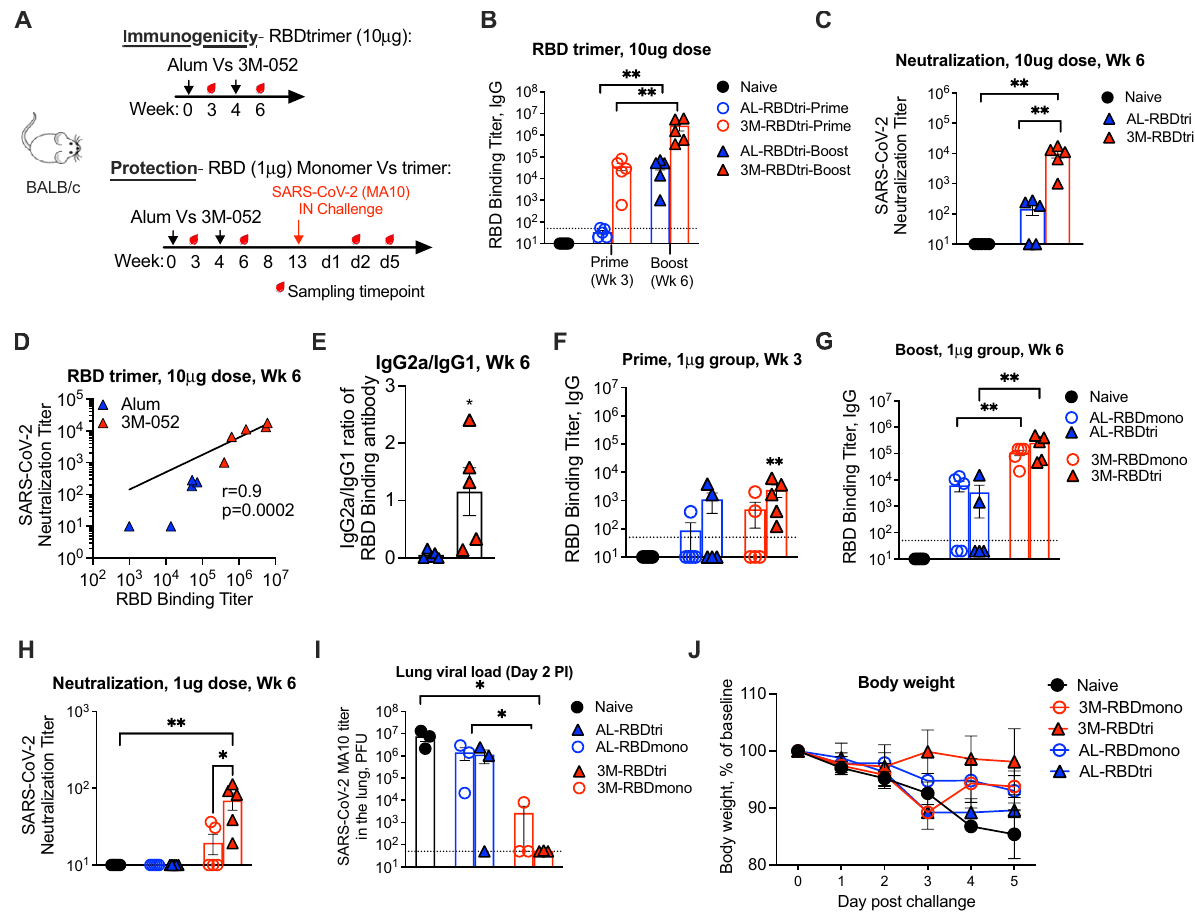
Fig. 2 RBD trimer adjuvanted with Alum-3M-052 induces a robust neutralizing antibody response and provides protection against SARS-CoV-2 challenge in mice. A The experimental schedule representing the timeline for the immunizations (study 1) and SARS-CoV-2 (MA10) challenge (study 2). Each immunization group has fi ve animals ( n = 5 mice per group). Study 1 ( B – E ): 6-week-old female BALB/c mice were immunized with RBD trimer (10 µ g/mice) either with Alum (blue) or with 3M-052-Alum (red) via intramuscular route at weeks 0 and 4. B Endpoint IgG titers against SARS-CoV-2 RBD measured in serum collected at week 2 post-prime and week 2 post-boost immunizations. Each sample was analyzed in duplicates. C Neutralization titer against live mNeonGreen SARS-CoV-2 virus. Each sample was analyzed in duplicates. D Correlations between neutralization titer and ELISA binding titers of RBD trimer antigen either with Alum (blue) and 3M-052 (red) adjuvants. The Spearman rank test was used to perform correlation analysis. E Bar graph shows the ratio of SARS-CoV-2 RBD-binding IgG2a and IgG1 antibody measurements. Each sample was analyzed in duplicates. Study 2 ( F – J ): Six-week-old female BALB/c mice were immunized either with RBD trimer or RBD monomer (1 µ g/mice) adjuvanted either with Alum (blue) or with 3M-052-Alum (red) via intramuscular route at weeks 0 and 4. Immunized mice were mock-infected, infected with 10 5 PFU SARS-CoV-2 MA10. F – G Endpoint IgG titers against SARS-CoV-2 RBD measured in serum collected at week 2 post-prime ( F ) and week 2 post-boost ( G ) immunizations. Each sample was analyzed in duplicates. (H) Neutralization titer against live mNeonGreen SARS-CoV-2 virus. Each sample was analyzed in duplicates. Circles indicate week 2 post- prime and fi lled triangle indicates week 2 post-boost immunizations. (I-J) Lung SARS-CoV-2 (MA10) viral titers of vaccinated animals compared to unvaccinated (I) and percent starting weight (J). In both studies, the black, blue, and red circles indicate naïve controls, alum, and alum-3M-052, respectively. Data are mean ± SEM. A two-sided Mann – Whitney U -test was used to compare between groups, * p < 0.05 and ** p < 0.01. (Fig. 2F). Further, the binding titer in the trimer/alum-3M-052 infection and did not show weight loss. 2 out of 3 mice in the group (geometric mean of 1.7 × 10 5 ) was 2-fold higher (not sig- monomer/alum-3M-052 group were also protected but showed a ni fi cant) compared to monomer/alum-3M-052 group (8 × 10 4 ). transient weight loss on day 3. In contrast, all but one animal in However, the neutralization titer against the live virus was mostly the alum-adjuvanted group was infected, showed high virus observed in the trimer/alum-3M-052 group and this was sig- replication, and showed some weight loss. These results demon- ni fi cantly higher than all other groups including monomer with strated that low dose (1 µg) RBD trimer protein adjuvanted with alum-3M-052 (Fig. 2H). To determine the protective potential, we alum-3M-052 induces neutralizing antibodies against SARS-CoV- challenged mice intranasally with a mouse-adapted SARS-CoV-2 2 and provides protection against intranasal SARS-CoV-2 chal- MA10 virus 28 and measured viral titer in the lungs at day 2 (3 out lenge in mice. of 5 mice in each group) and weight loss until day 5 (2 out of 5 mice in each group) (Fig. 2I, J). As expected, all control animals RBD trimer protein induces both neutralizing and non- showed a very high viral titer of about 10 7 pfu/lung on day 2 and neutralizing antibodies with effector function and Th1-baised exhibited weight loss from days 3 to 5. Impressively, all mice in CD4 T cells in macaques . To further investigate the translational the trimer/alum-3M-052 group were completely protected from potential of RBD trimer protein as a vaccine for COVID-19, we NATURE COMMUNICATIONS| (2021) 12:3587